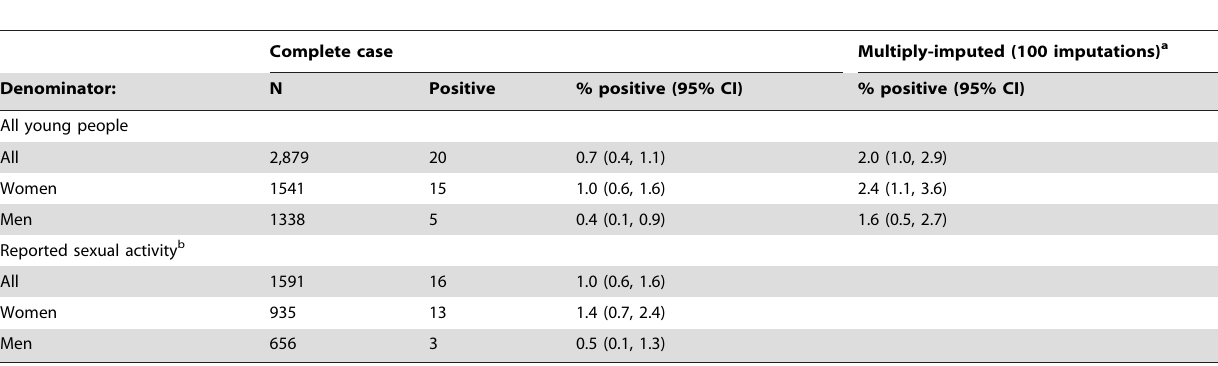
Table 3. Estimates of prevalence of chlamydia Infection i) for all participants and ii) those reporting sexual activity, by gender, with and without sensitivity test for bias due to missing data.